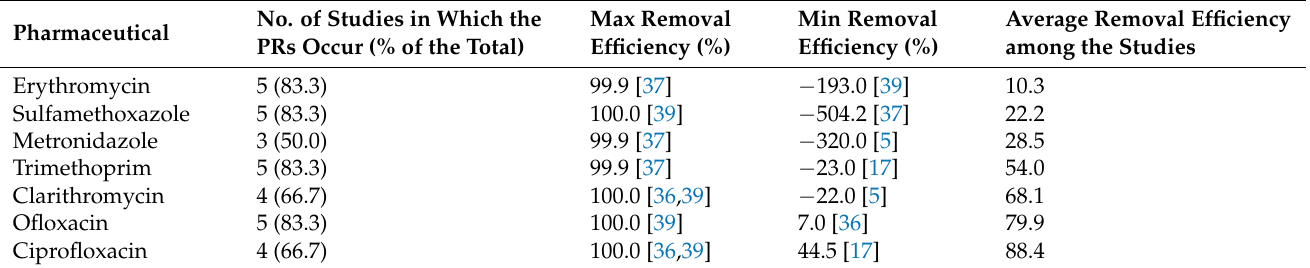
Table 7. Removal efficiencies of the PRs most commonly found in